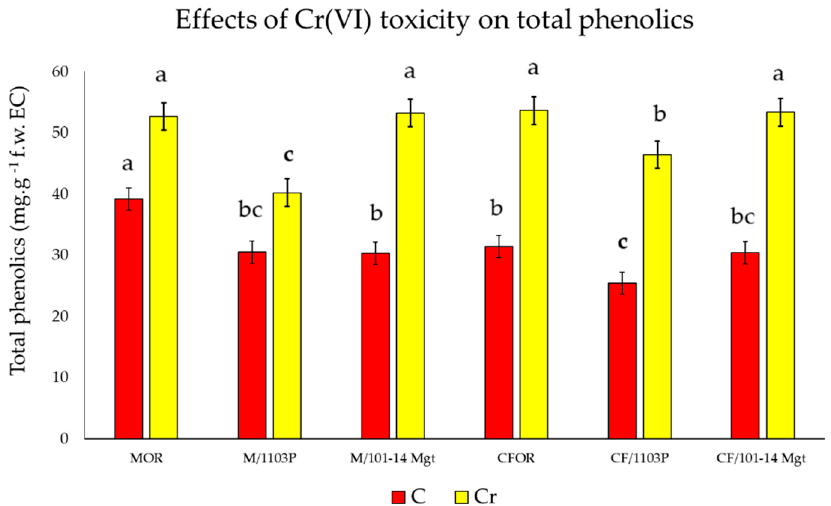
Figure 4. Leaf total phenolic content after sixty days of Cr(VI) treatment in own-rooted (OR) Merlot (M) and Cabernet Franc (CF) vine varieties and vines grafted to 1103P and 101-14 Mgt rootstocks. C: control, Cr: Cr(VI) treatment. (F:26.14). Different letters represent significant difference of p < 0.05. Ι n the examined samples, sixty days from the beginning of experimentation the leaf